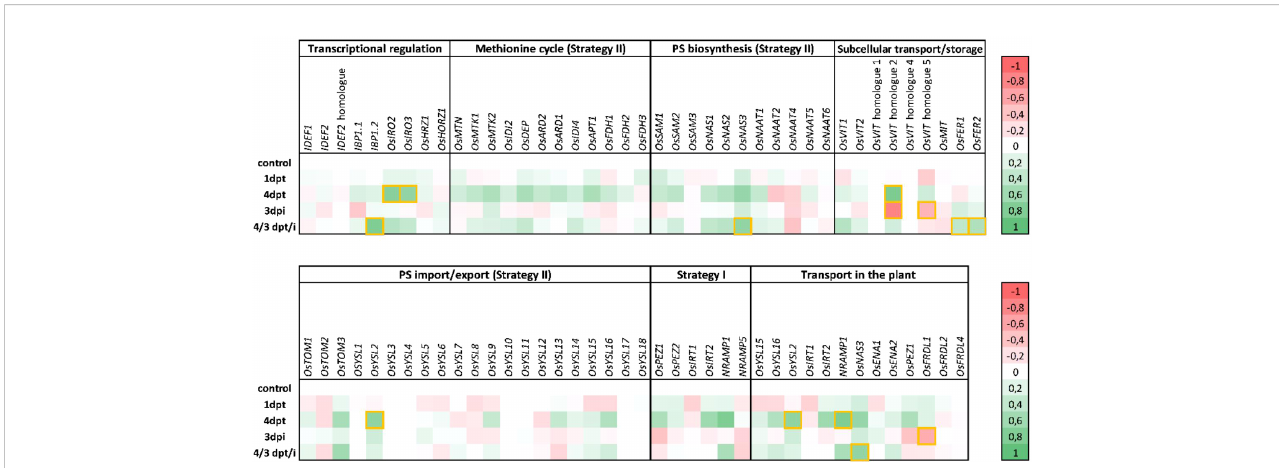
FIGURE 1 Diproline-induced resistance in rice is associated with general upregulation of iron homeostasis genes. Fe-homeostasis genes were selected based on a thorough literature review (Lemanceau et al., 2009; Expert et al., 2012; Kobayashi et al., 2014; Aznar and Dellagi, 2015; Aznar et al., 2015; Naranjo-Arcos and Bauer, 2016; Verbon et al., 2017). The fi gure shows RNA seq based relative expression levels of these genes in rice roots at one and four days post foliar treatment with 500 µM diproline (1 dpt and 4 dpt, respectively), three days post Meloidogyne graminicola inoculation (3 dpi) and upon a combination of diproline treatment and nematode inoculation (4/3 dpt/i). Relative expression levels are expressed as log2fold changes compared to the same-aged, mock-treated uninoculated plants control plants. Green and red represent transcriptional induction and repression, respectively. Yellow- boxed cells indicate statistically signi fi cant up- or downregulation (p<0.05). PS = phytosiderophore. Detailed per gene transcription levels can be found in Supporting Information 4.